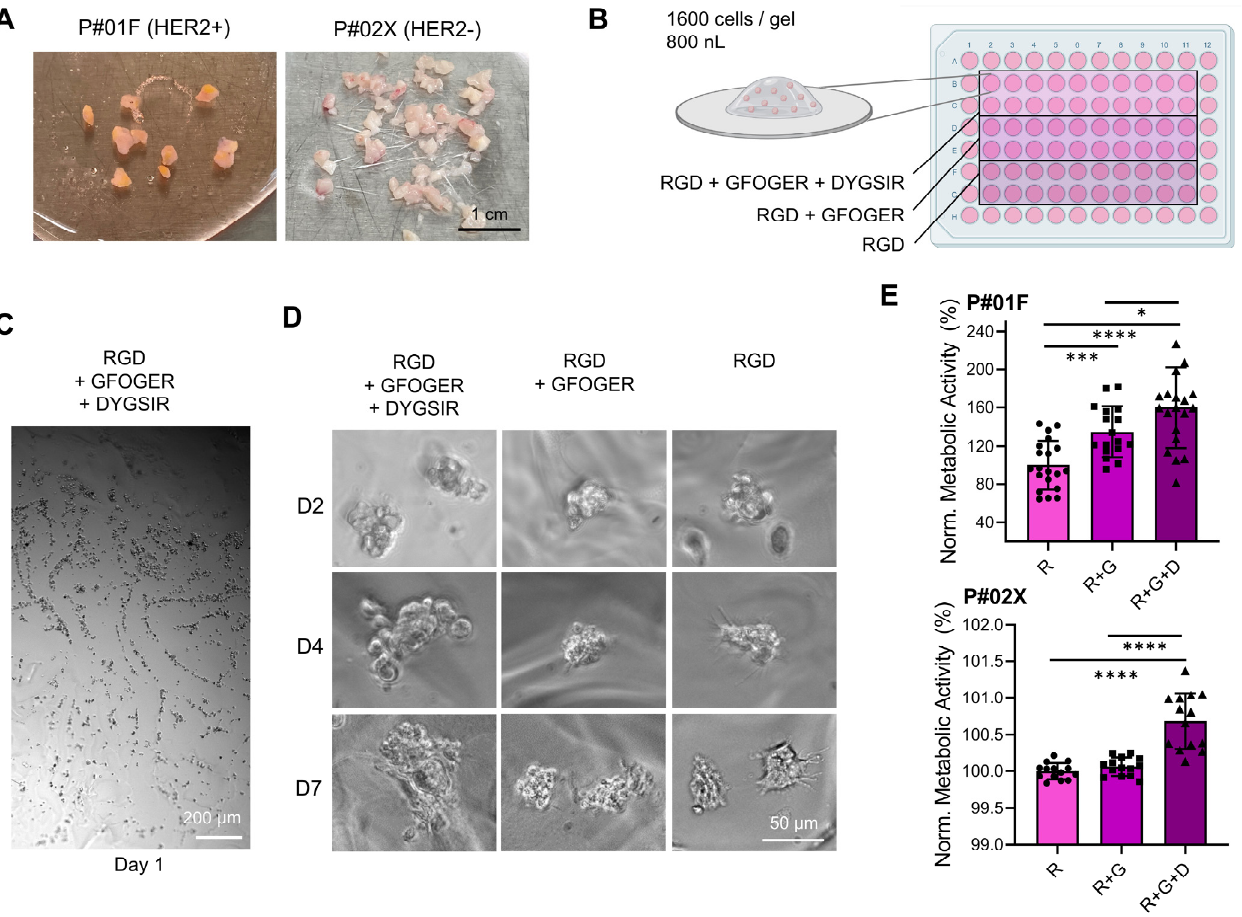
Figure 2. Effect of peptide functionalization on breast cancer patient-derived tumor tissues digested and bioprinted as individual cells in PEG hydrogels (P#01F and P#02X). ( A ) Photographs of tumor tissues upon excision. ( B ) Schematic of bioprinted well-plate conditions. ( C ) Overview of single cell distribution in PEG hydrogel containing RGD + GFOGER + DYIGSR one day after single cell bioprinting (P#02X). ( D ) Brightfield images of cells in PEG hydrogels functionalized with different peptides over time, showing enhanced organoid formation for the PEG-(RGD + GFOGER + DYIGSR) formulation (P#01F). ( E ) Metabolic activity after 7 days of culture, normalized to the PEG with RGD group (R) for each tumor (R = RGD, G = GFOGER, D = DYIGSR). Circles, squares, and triangles show individual datapoints. Histograms show means ± SD, n = 17–20 technical replicates (* p < 0.01, *** p < 0.001, **** p < 0.0001).